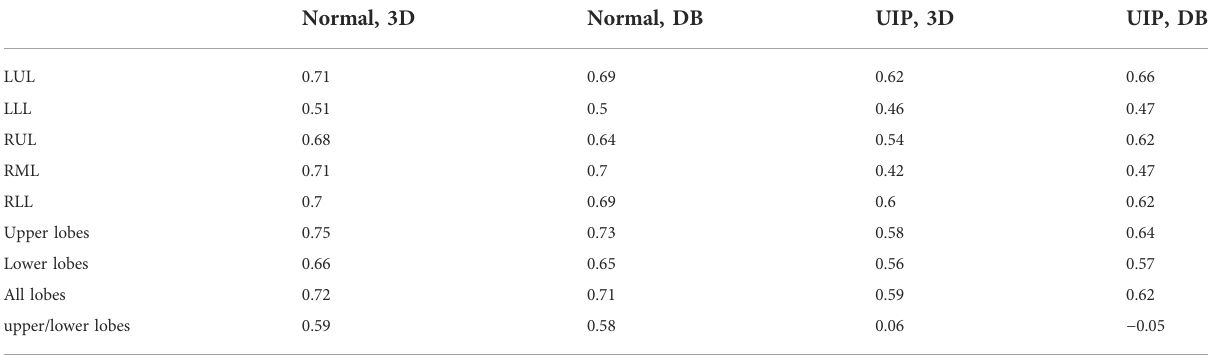
TABLE 4 Regional correlation of TF with 3D and dorso-basal